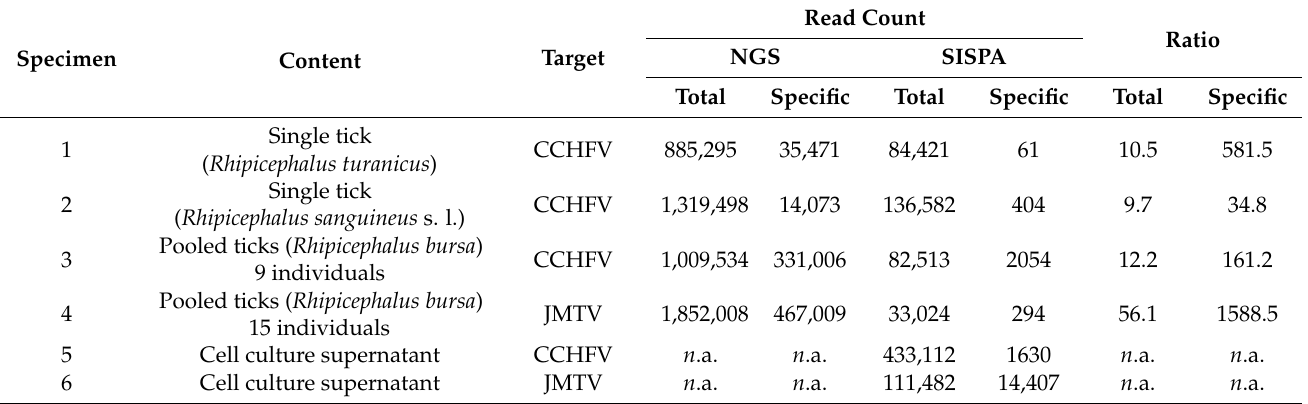
Table 1. Study specimens and assay-based read